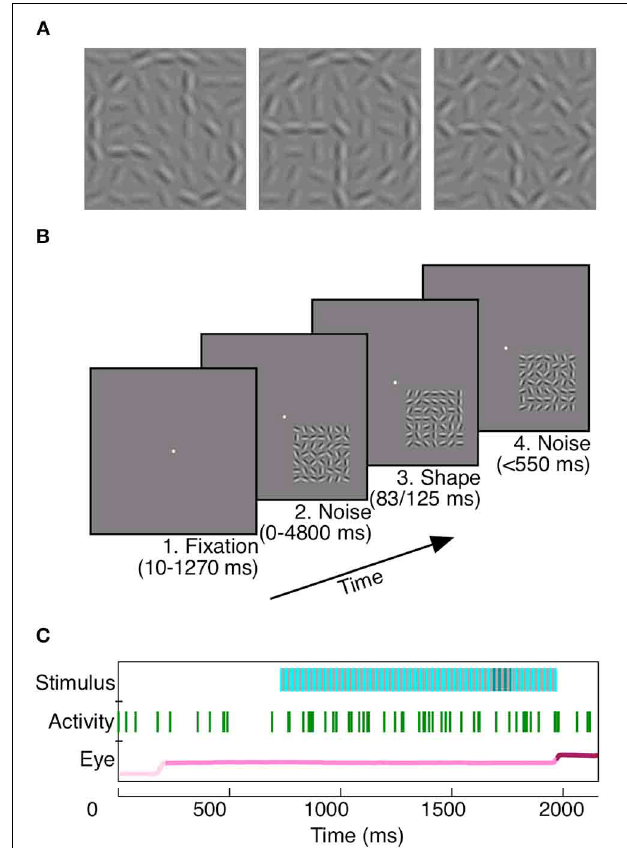
FIGURE 1 | Rapid shape detection task. Each monkey was trained to detect the appearance of any of three shapes (A) . For Monkey Z, each of the three shapes could appear at any one of four orientations, for a total of 12 potential shape frames. In (A) , shapes are shown at a higher contrast than background for the purpose of illustration; noise and shape elements were at equal contrasts during recording. The task was to remain fixated on a centrally located point (B1) during noise stimulus presentation (B2) . When a shape briefly appeared, embedded in the noise stimulus ( B3 , same shape as A middle), the animals were required to make a saccade to the location of the stimulus within 150–550ms (B4) to receive a juice reward. Our analyses rely on three simultaneously recorded variables: the presented stimulus, neuronal activity, and eye position (C) . To prevent the animals from using motion cues for shape detection, static noise frames (light blue, C , Stimulus), in which the random noise pattern did not vary on successive presentations, were interleaved with redrawn noise frames (gray, C , Stimulus). When a shape appeared (dark blue, C , Stimulus), it was embedded in the static noise frames. Green vertical lines indicate spikes recorded during the trial from an example unit. The eye position in light pink prior to fixation, pink during fixation, and dark pink subsequent to the saccade.